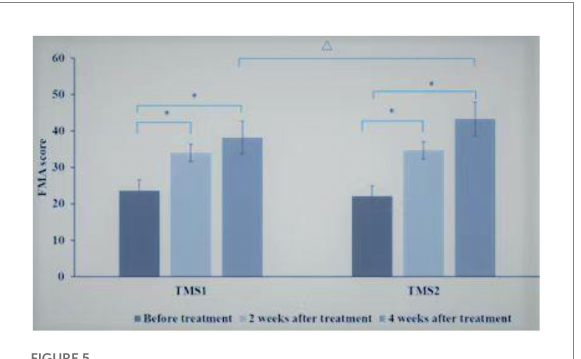
FIGURE 5 Comparison of FMA scores between TMS1 group and TMS2 group before and after treatment. * p < 0.001; ∆ p =